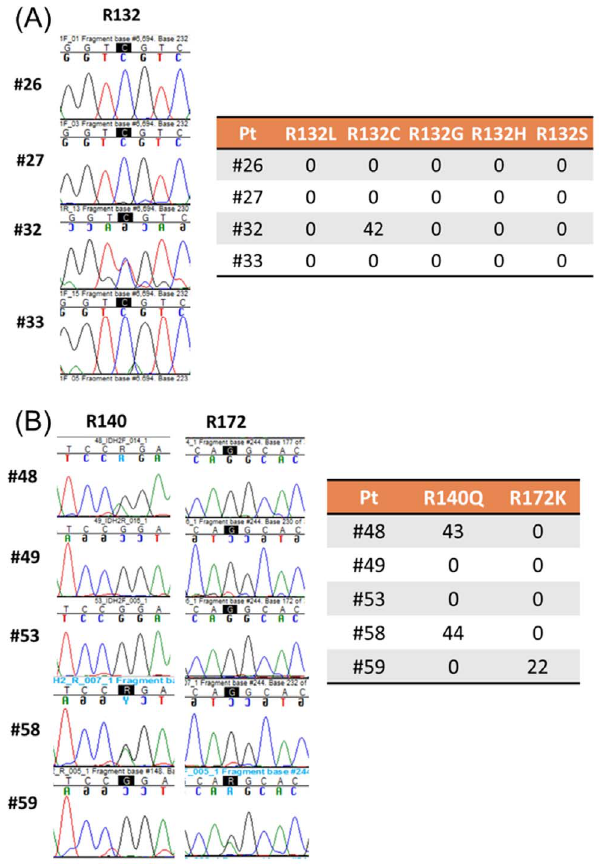
Figure 5. Comparison of the read-out of the bead-based assay and the Sanger sequencing in selected patients’ samples for IDH1 (A) and IDH2 (B) genes.